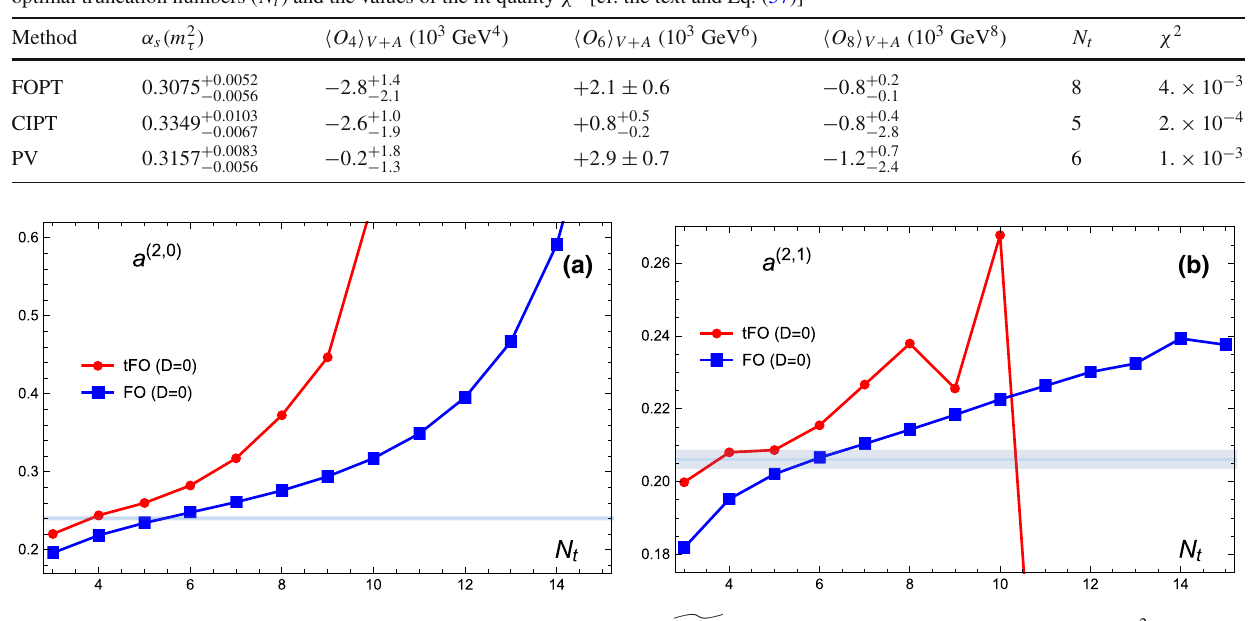
Fig. 11 The same as in Fig. 10, but this time for the methods FOPT (’FO’) and (cid:2) FOPT (’tFO’). The fixed QCD coupling values are α s ( m 2 τ ) = 0 . 3075 and 0 . 3074,